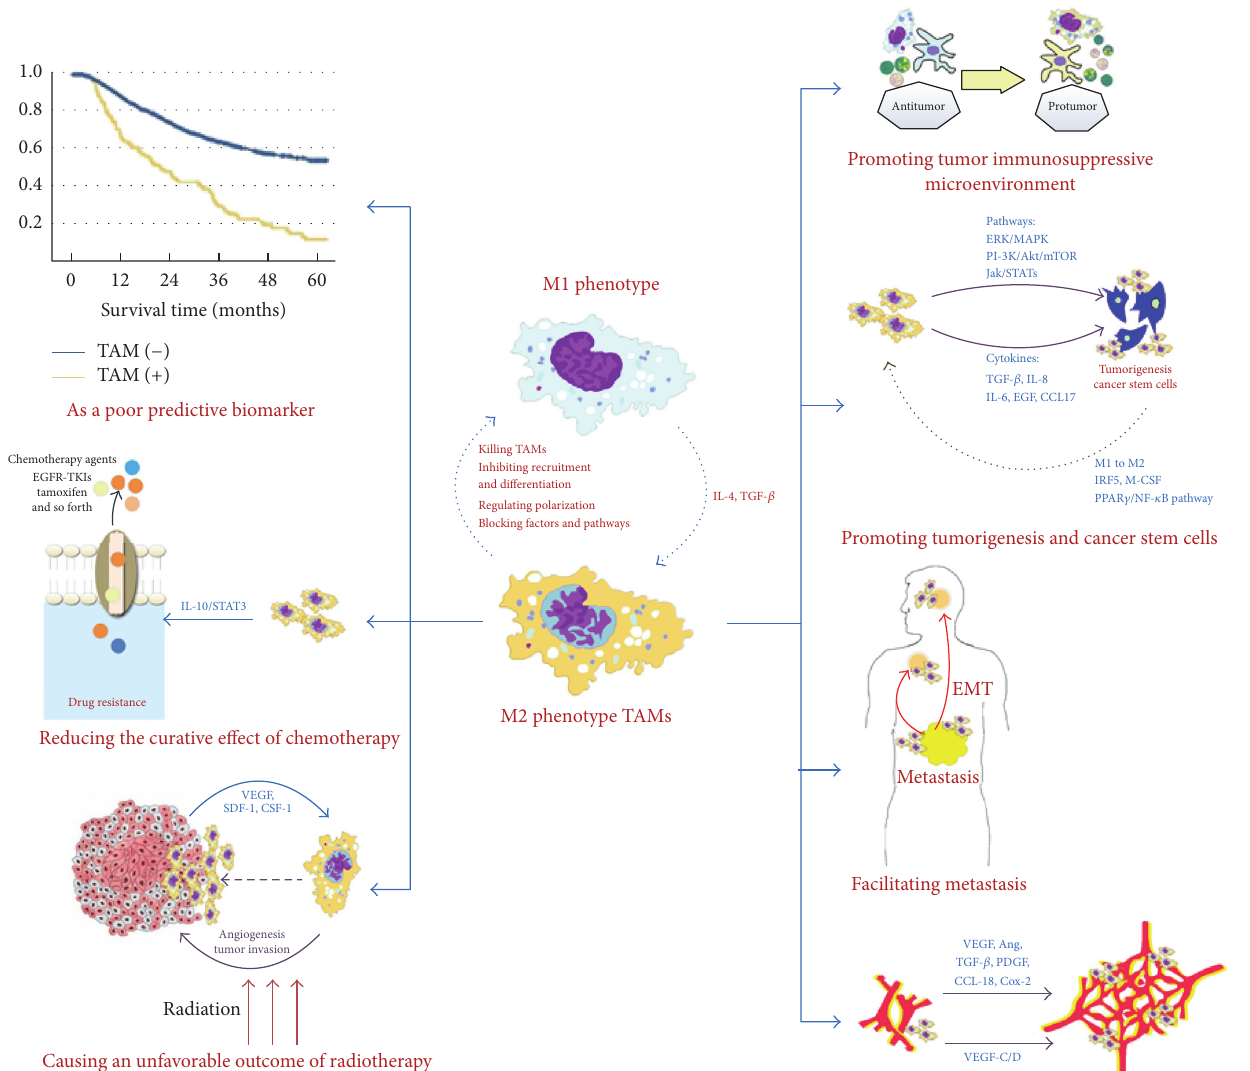
Figure 1: TAMs promote tumor